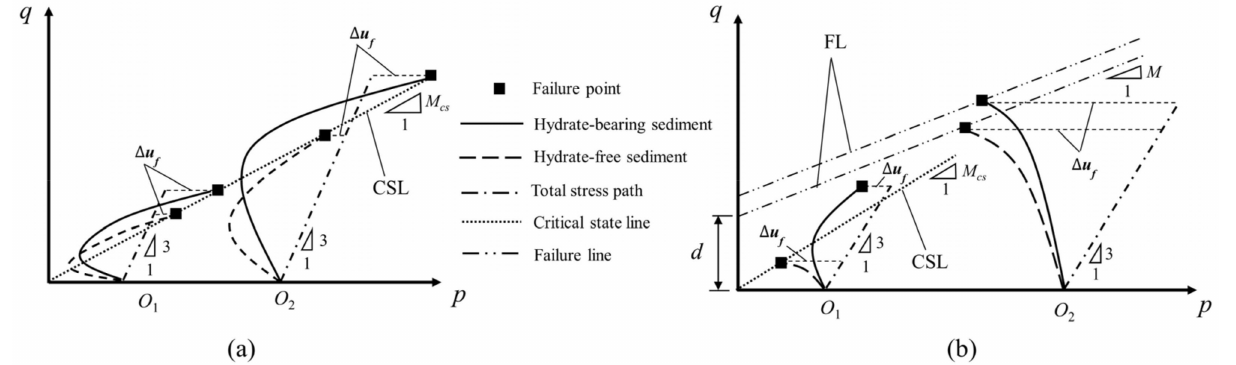
Figure 8. Typical stress paths of different sediments in q − p (cid:48) plane. ( a ) sand sediments, ( b ) clayey- silt